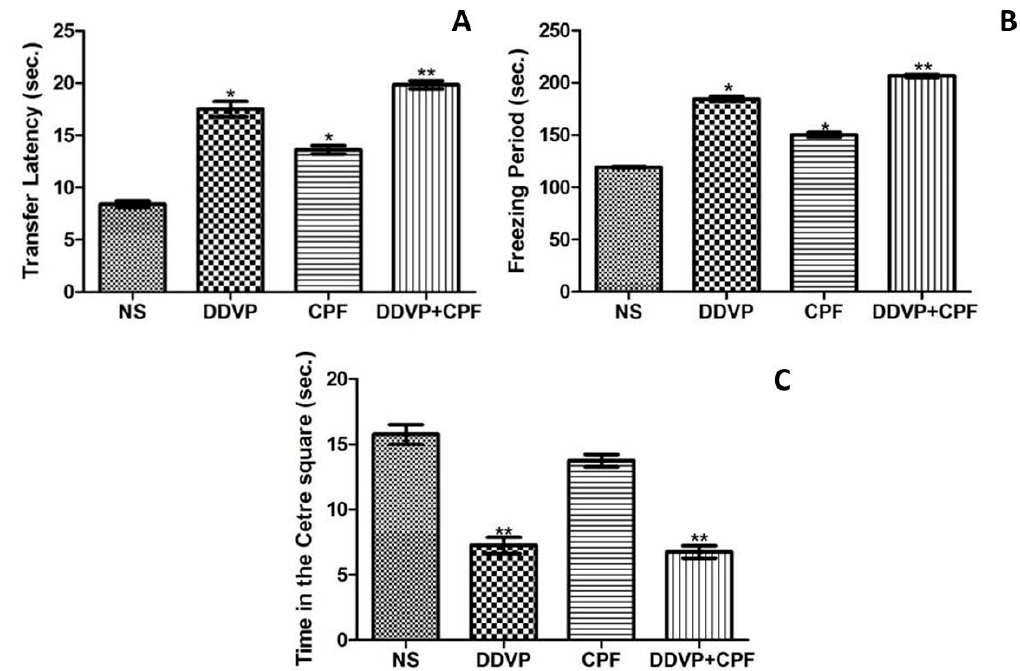
Figure 3. The effects of oral exposures to normal saline (NS), dichlorvos (DDVP) or/and chlorpyrifos (CPF) on: ( A ) fear learning (transfer latency) in the elevated plus maze paradigm; and ( B , C ) anxiety-related behavious (freezing period and time in center squares) in the open field test paradigm. Double asterisks (**) indicate a significant ( p ≤ 0.05) increase ( A , B ) or decrease ( C ) when compared with NS, other groups, and/or CPF rats only, while a single asterisk (*) indicates significant ( p ≤ 0.05) increase when compared with NS ( A , B ). One-way analysis of variance (ANOVA) with a post hoc Bonferroni’s multiple comparison test.